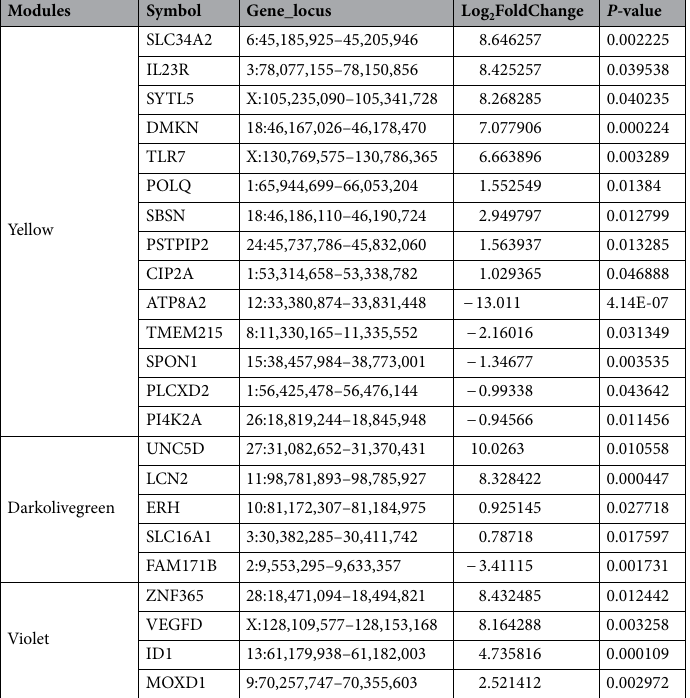
Table 1. DEs contained within the darkolivegreen, violet and yellow modules.